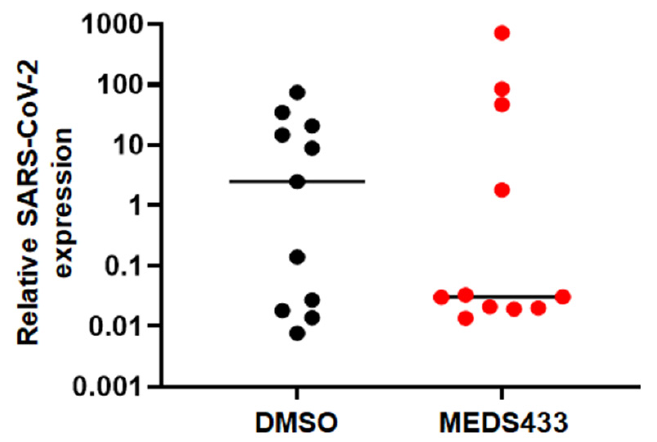
Figure 4. Effects of MEDS433 on SARS-CoV-2 replication in kidney organoids. Kidney organoids were infected with 100 PFU of SARS-CoV-2/01/human/2020/SWE per organoid and simultaneously treated with 0.5 µ M MEDS433 or vehicle (DMSO) as a control. After 48 h, kidney organoids were washed, and harvested for analysis of SARS-CoV-2 E RNA levels by RT-qPCR. The results from three independent batches of kidney organoids are shown with line at mean relative to mock-infected controls; batches 1 and 2 contained 3 groups of 4 pooled organoids, batch 3 contained 5 groups of 4 pooled organoids per treatment